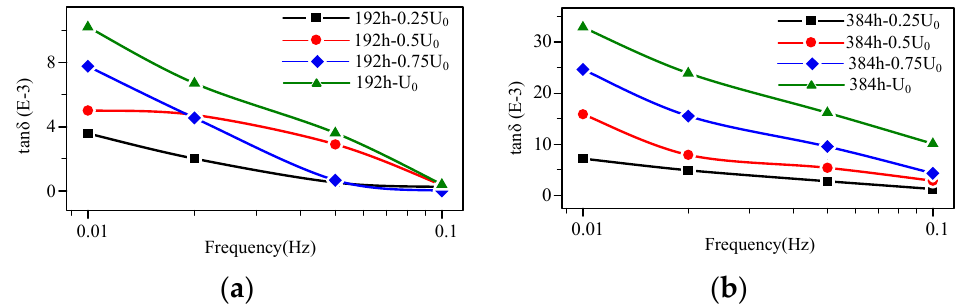
Figure 10. High-voltage FDS of cable at the middle aging stage: ( a ) aging time 192 h; ( b ) aging time 384 h. The high-voltage FDS curves of the cable at the late aging stage (after 384 h) are shown in Figure 11a,b. At the late aging stage, the cable tan δ value continues to increase,